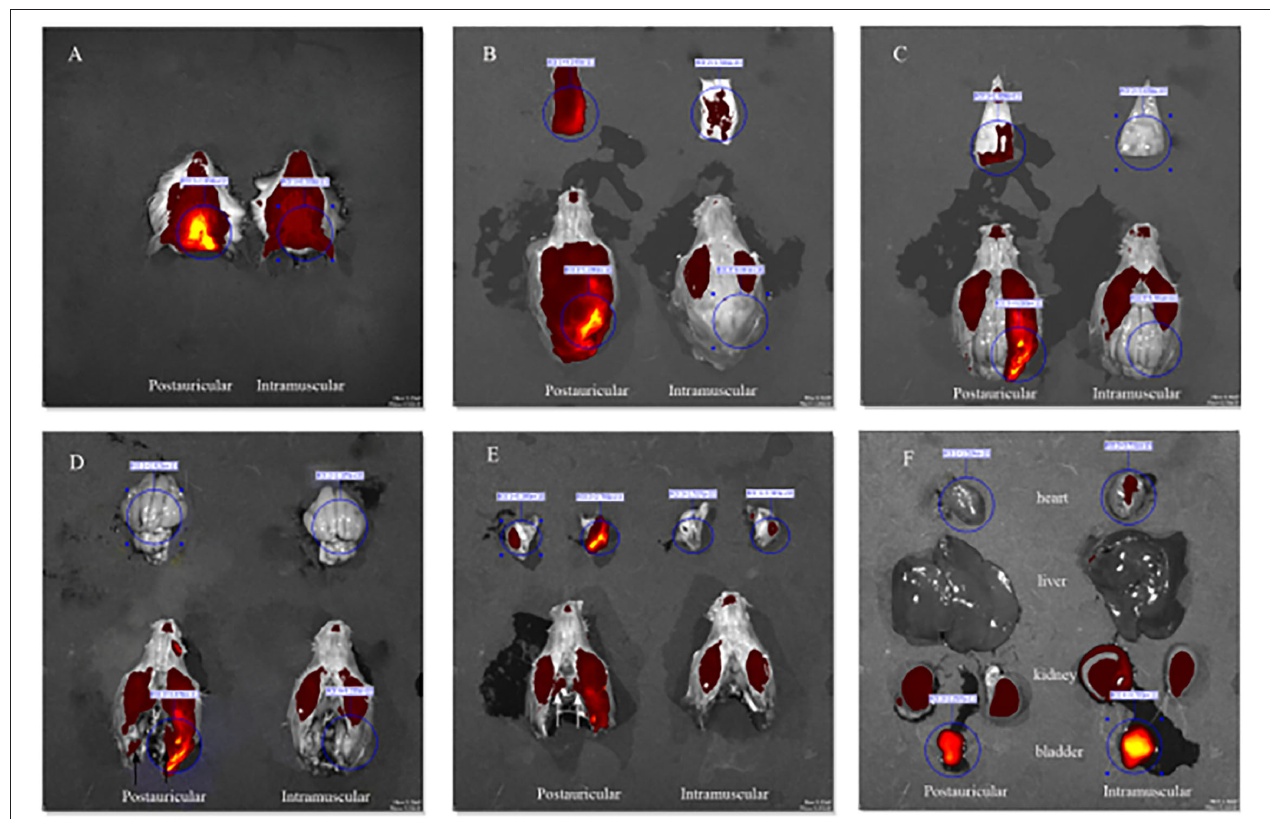
FIGURE 4 | Drug distribution in the head (A) , the scalp (B) , parietal bone (C) , cerebrum ( D , black arrow, sigmoid sinus), temporal bone ( E , white arrow, cavernous sinus), and internal organs (F) .